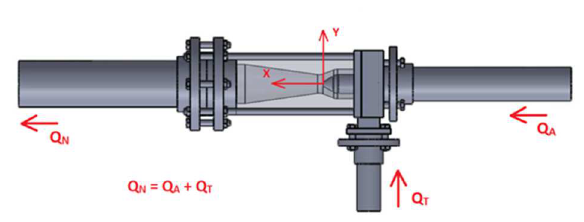
Fig. 1a. Design of the swirl flow generator .